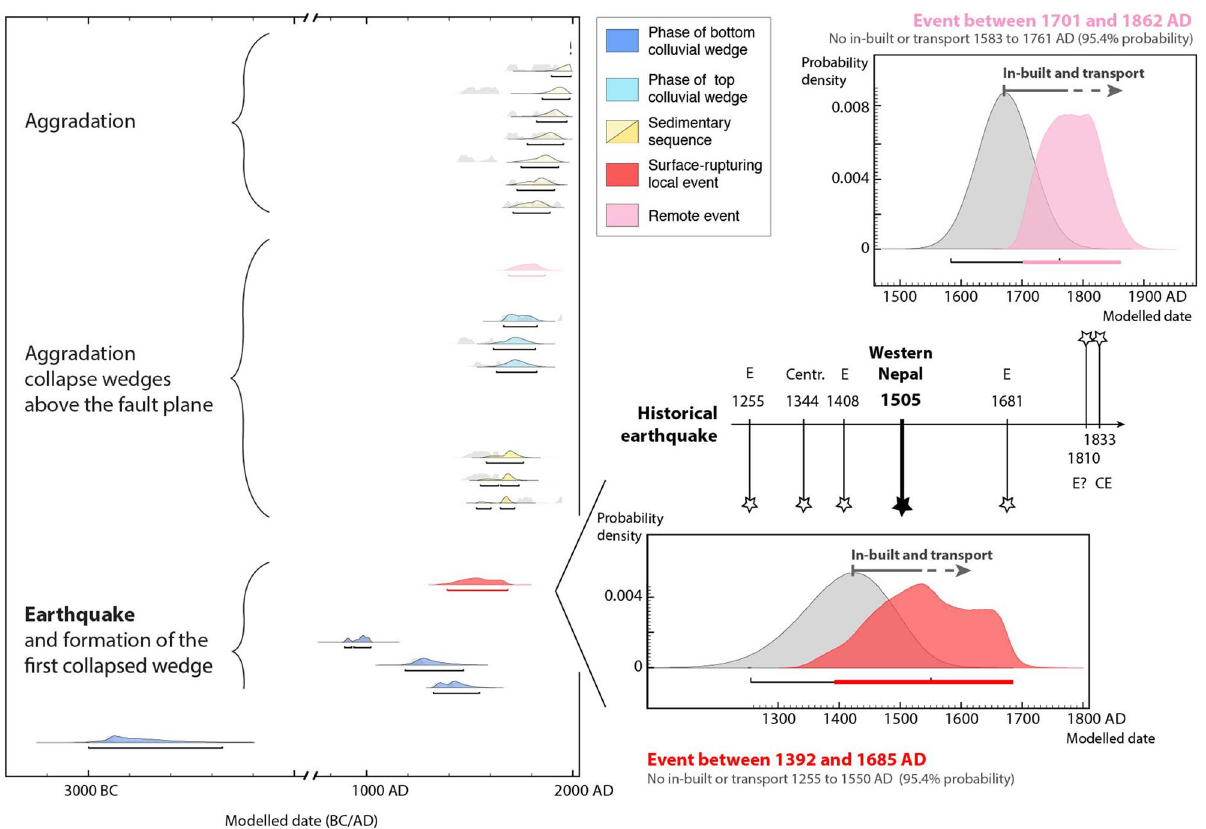
Figure 7. Detrital charcoal radiocarbon ages with inbuilt age as a function of the depth. In gray, calculated probability density spectra for possible ground shaking events on -or off- fault. The maximum and minimum sedimentation rate are represented in blue. Figure generated with Adobe illustrator CS6 (http:// www. adobe. com/ fr/ produ cts/ illus trator.